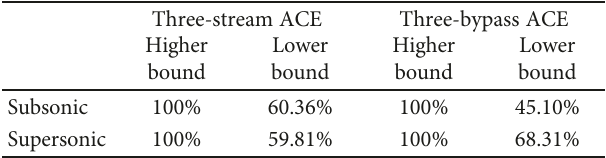
Table 10: Comparison of improvement of installed performance. Table 11: Comparison of uninstalled thrust variation